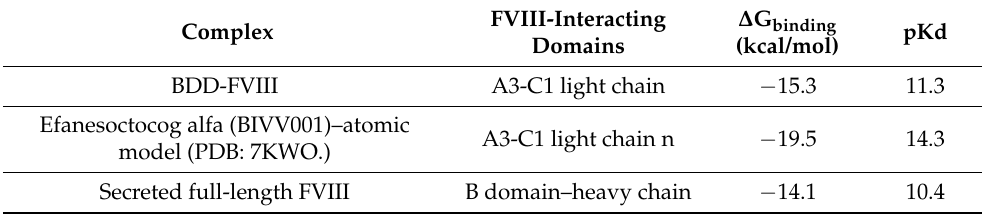
Table 2. PRODIGY rescoring of PYDOCK-predicted complexes .